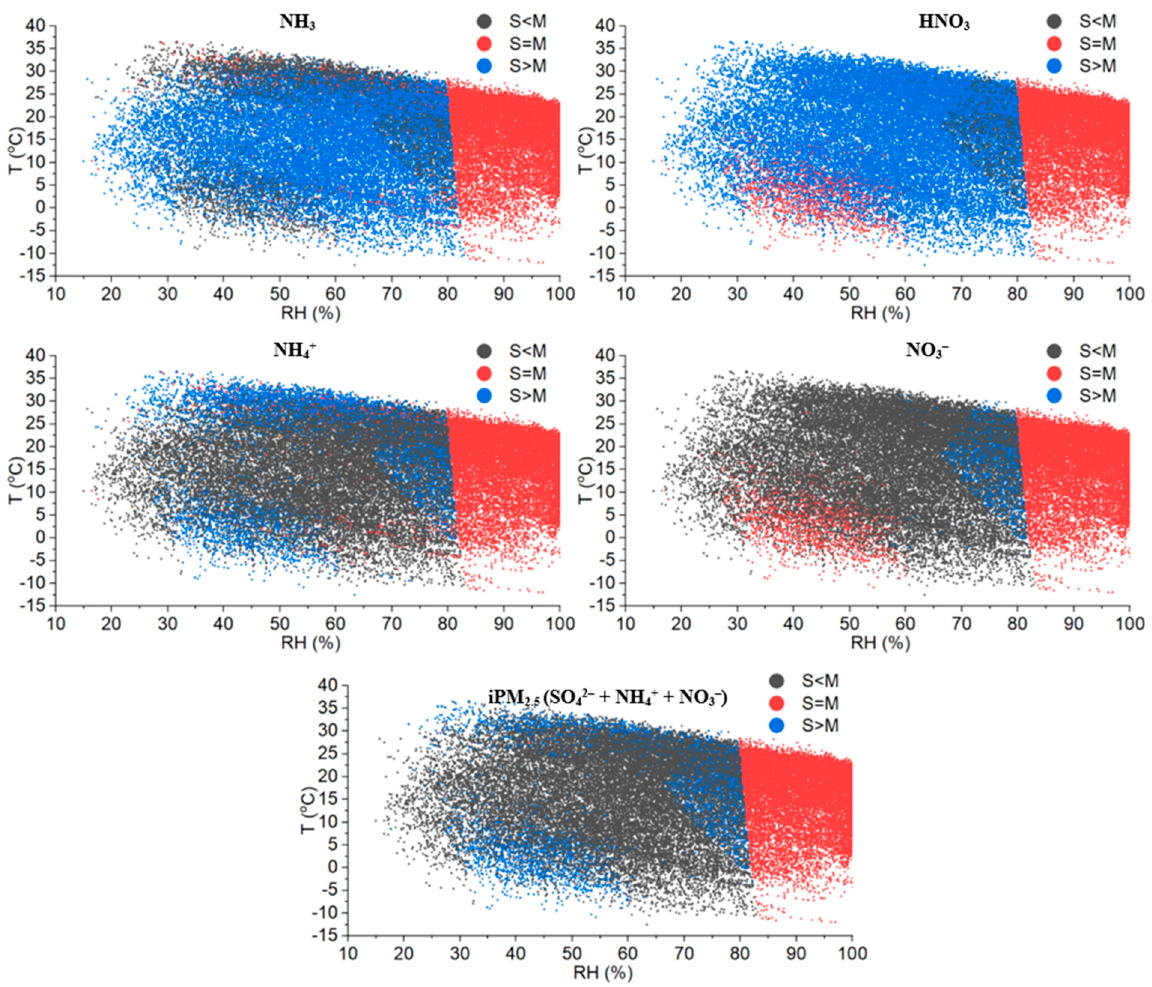
Figure 8. The difference of predictions using stable and metastable setups at the YRK site (S: stable; M: metastable).